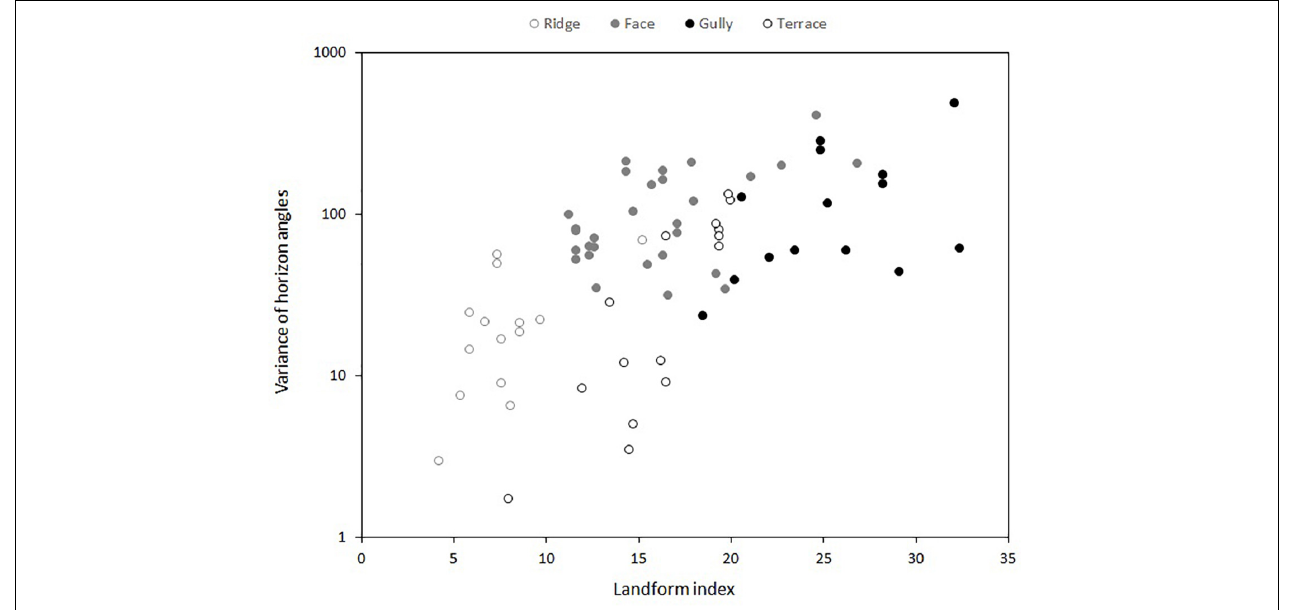
FIGURE 1 | Relationship between landform index (McNab, 1993) and four subjectively-determined topographic positions at five different localities. Landform index is the mean of the angle to the horizon in eight equidistant compass directions at each sampling point. Y -axis shows the variance of these eight horizon angles at each sampling